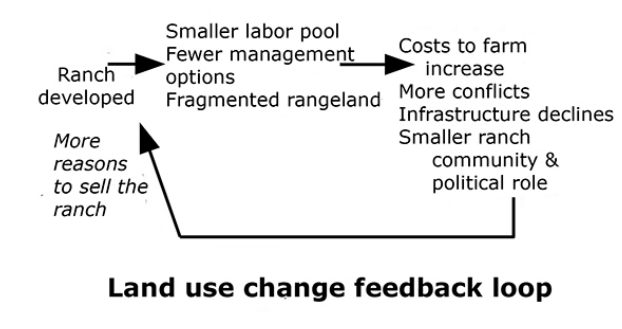
Fig. 8. . Feedback loop accompanying rangeland